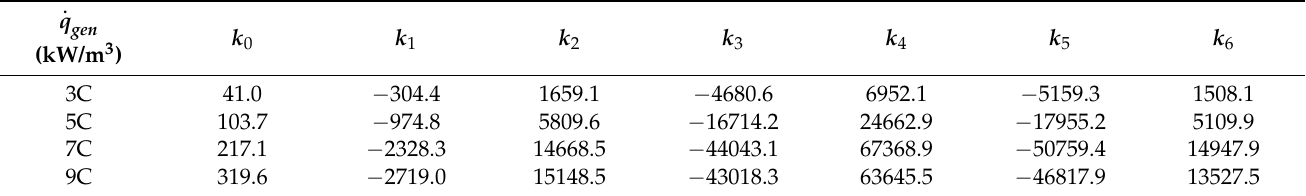
Table 3. The constants in the battery heat generation rate fitted equations. Reproduced with permis- sion from Elsevier